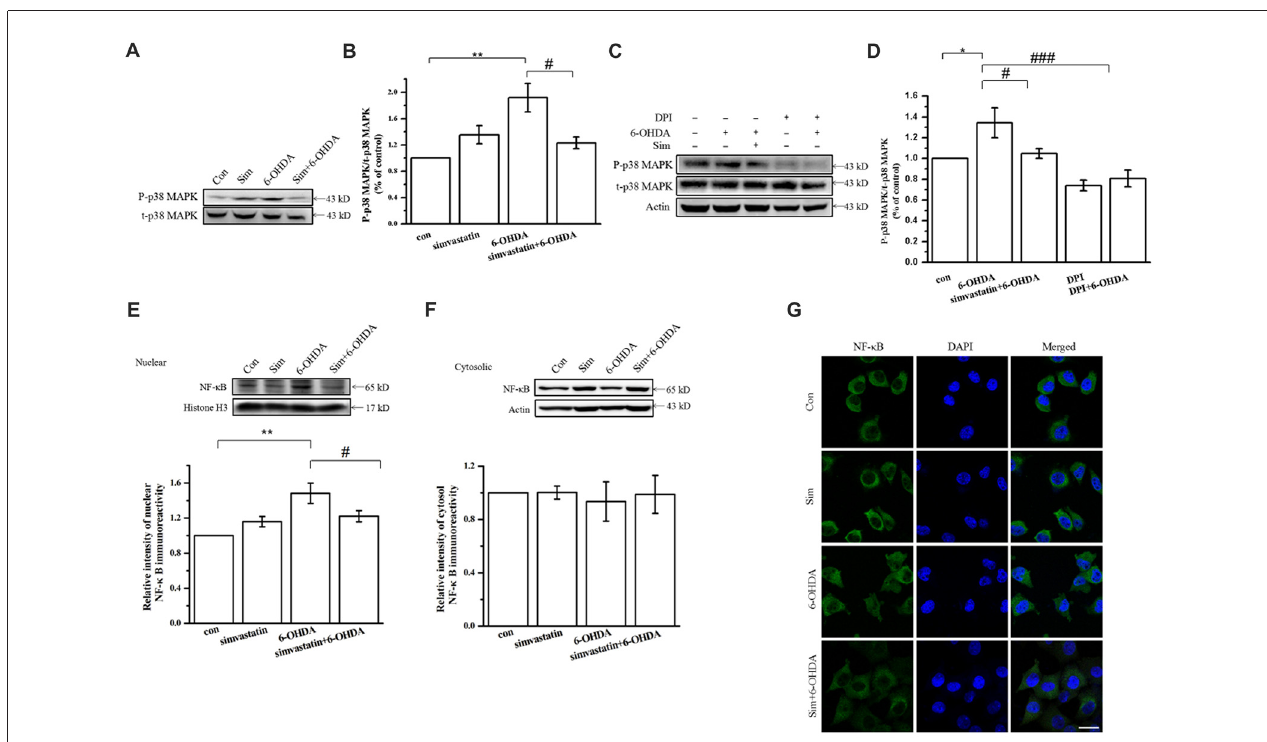
FIGURE 4 | Simvastatin can inhibit 6-OHDA-induced activation of p38 mitogen-activated protein kinase (MAPK) and nuclear factor- κ B (NF- κ B) downstream of NADPH oxidase in SH-SY5Y cells. SH-SY5Y cells were co-treated with 1 µ mol/L simvastatin and 100 µ mol/L 6-OHDA. (A) Expression of Phospho-p38 mitogen-activated protein kinase (P-p38 MAPK) and t-p38 MAPK detected by western blot after 24 h. (B) Relative quantitative analysis of P-p38 MAPK and t-p38 MAPK expression. (C) After 5 µ mol/L diphenyleneiodonium (DPI) pretreatment for 60 min, 1 µ mol/L simvastatin and 100 µ mol/L 6-OHDA were added to the culture; expression of P-p38 MAPK and t-p38 MAPK detected after 24 h. (D) Relative quantitative analysis of P-p38 MAPK and t-p38 MAPK expression in cells pretreated with DPI. Expression of nuclear NF- κ B (E) and cytosolic NF- κ B (F) detected by western blot after 6 h and relative quantitative analysis. (G) Cells were fixed, ruptured after 6 h co-treatment, then incubated with anti-NF- κ B primary antibody and fluorescent-labeled secondary antibody. Nuclear translocation of NF- κ B detected using confocal fluorescence microscopy. Scale bar, 30 µ m. Data were obtained from three independent experiments. Statistical analysis by Dunnett’s T3 or LSD post hoc test based on ANOVA; data expressed as mean ± SEM. ∗ P < 0.05, ∗∗ P < 0.01, # P < 0.05, ### P <